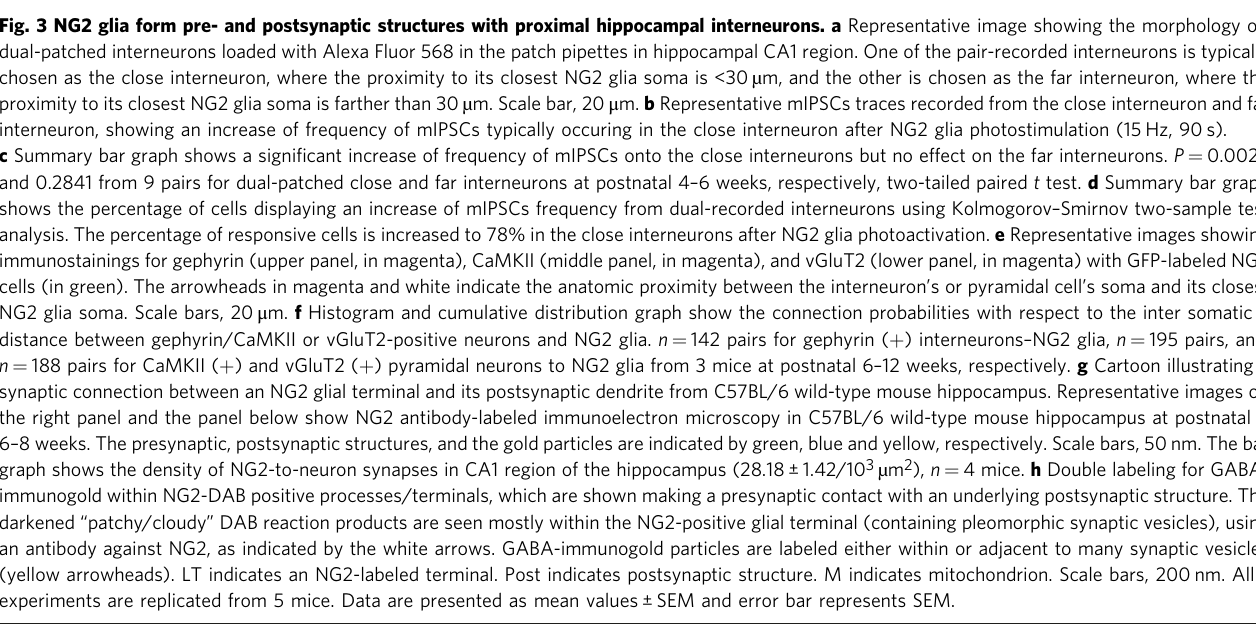
Fig. 3 NG2 glia form pre- and postsynaptic structures with proximal hippocampal interneurons. a Representative image showing the morphology of dual-patched interneurons loaded with Alexa Fluor 568 in the patch pipettes in hippocampal CA1 region. One of the pair-recorded interneurons is typically chosen as the close interneuron, where the proximity to its closest NG2 glia soma is <30 µ m, and the other is chosen as the far interneuron, where the proximity to its closest NG2 glia soma is farther than 30 µ m. Scale bar, 20 μ m. b Representative mIPSCs traces recorded from the close interneuron and far interneuron, showing an increase of frequency of mIPSCs typically occuring in the close interneuron after NG2 glia photostimulation (15 Hz, 90 s). c Summary bar graph shows a signi fi cant increase of frequency of mIPSCs onto the close interneurons but no effect on the far interneurons. P = 0.0022 and 0.2841 from 9 pairs for dual-patched close and far interneurons at postnatal 4 – 6 weeks, respectively, two-tailed paired t test. d Summary bar graph shows the percentage of cells displaying an increase of mIPSCs frequency from dual-recorded interneurons using Kolmogorov – Smirnov two-sample test analysis. The percentage of responsive cells is increased to 78% in the close interneurons after NG2 glia photoactivation. e Representative images showing immunostainings for gephyrin (upper panel, in magenta), CaMKII (middle panel, in magenta), and vGluT2 (lower panel, in magenta) with GFP-labeled NG2 cells (in green). The arrowheads in magenta and white indicate the anatomic proximity between the interneuron ’ s or pyramidal cell ’ s soma and its closest NG2 glia soma. Scale bars, 20 μ m. f Histogram and cumulative distribution graph show the connection probabilities with respect to the inter somatic distance between gephyrin/CaMKII or vGluT2-positive neurons and NG2 glia. n = 142 pairs for gephyrin ( + ) interneurons – NG2 glia, n = 195 pairs, and n = 188 pairs for CaMKII ( + ) and vGluT2 ( + ) pyramidal neurons to NG2 glia from 3 mice at postnatal 6 – 12 weeks, respectively. g Cartoon illustrating a synaptic connection between an NG2 glial terminal and its postsynaptic dendrite from C57BL/6 wild-type mouse hippocampus. Representative images on the right panel and the panel below show NG2 antibody-labeled immunoelectron microscopy in C57BL/6 wild-type mouse hippocampus at postnatal 6 – 8 weeks. The presynaptic, postsynaptic structures, and the gold particles are indicated by green, blue and yellow, respectively. Scale bars, 50 nm. The bar graph shows the density of NG2-to-neuron synapses in CA1 region of the hippocampus (28.18 ± 1.42/10 3 µ m 2 ), n = 4 mice. h Double labeling for GABA- immunogold within NG2-DAB positive processes/terminals, which are shown making a presynaptic contact with an underlying postsynaptic structure. The darkened “ patchy/cloudy ” DAB reaction products are seen mostly within the NG2-positive glial terminal (containing pleomorphic synaptic vesicles), using an antibody against NG2, as indicated by the white arrows. GABA-immunogold particles are labeled either within or adjacent to many synaptic vesicles (yellow arrowheads). LT indicates an NG2-labeled terminal. Post indicates postsynaptic structure. M indicates mitochondrion. Scale bars, 200 nm. All experiments are replicated from 5 mice. Data are presented as mean values ± SEM and error bar represents